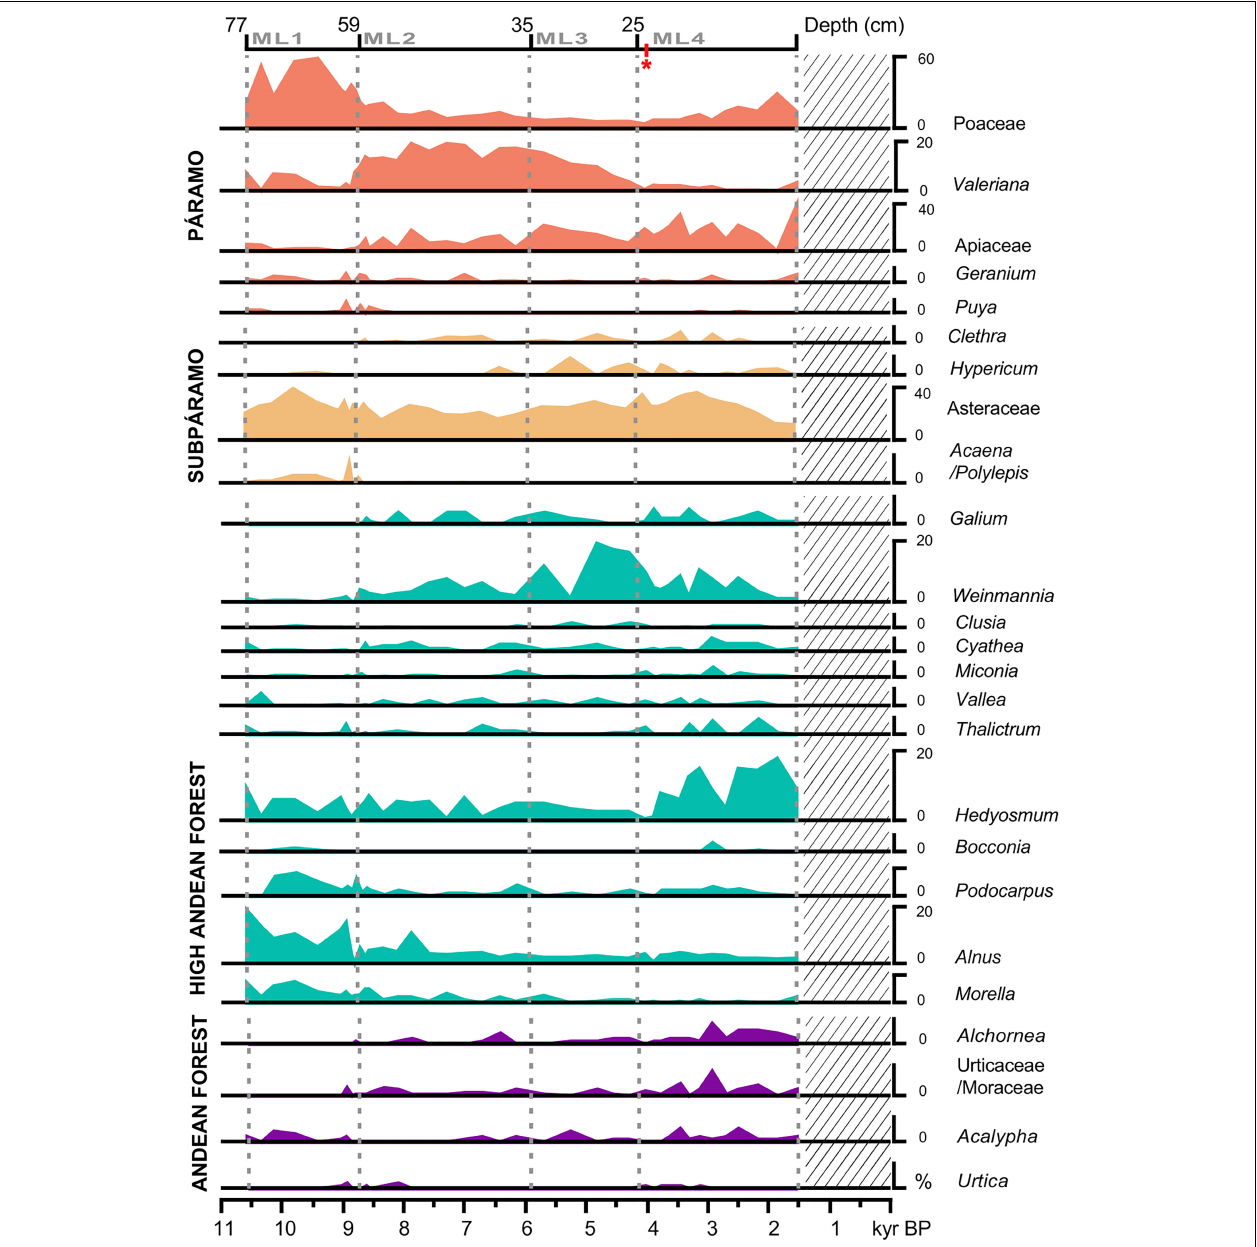
FIGURE 3 | Summary pollen diagram of MAR19-II core from Monquentiva showing main regional taxa ( > 10%) organized by vegetation groups. Dashed gray lines indicate the limits for Monquentiva local pollen zones ML1 to ML4 from the CONISS zonation. The lattice denotes a gap in the MAR19-II sedimentary record. The red * indicates one sample where the pollen count was below 300 grains and reached 258